Question: Briefly state, in one sentence, what is plotted here.
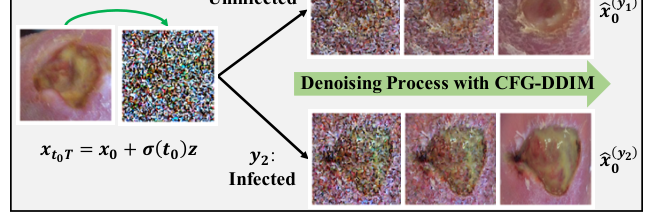
Answer: Synthesizing conditional DFU images using ConDiff. A guide image x0 is perturbed with Gaussian noises that are then removed pro- gressively using a CFG-DDIM sampling technique (see Algorithm. 1), conditioned on the infection status. This process gradually projects x0 to guided synthetic images of conditions: ˆx(y1) 0 and ˆx(y2) 0 .